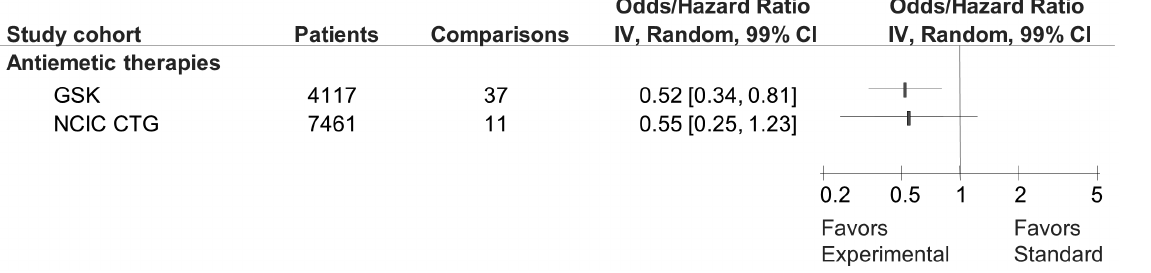
Figure 5. Forest plot of pooled data on primary outcome for studies of antiemetic therapies conducted by GlaxoSmithKline (GSK) and National Cancer Institute Canada Clinical Trials Group (CTG). Given the prevalence of studies involving antiemetic treatments, we include this subgroup analysis. The summary pooled estimate (odds/hazard ratio) is indicated by rectangles, with the lines representing 99% confidence intervals (CIs). The test of interaction is statistically non-significant between the two cohorts but the number of trials was small.